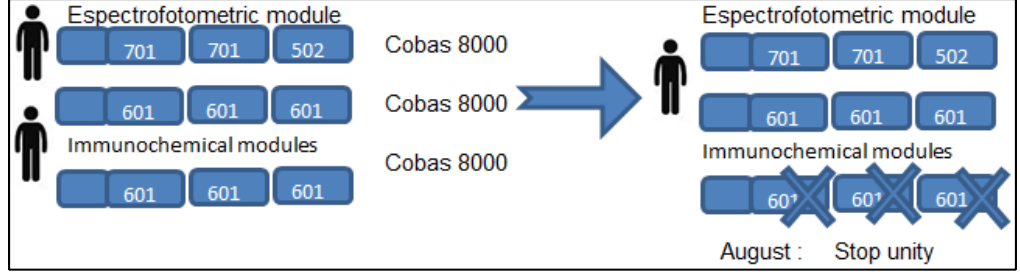
Figure 1. One operating unit Cobas 8000-701 and two units Cobas 8000-601 with staff allocation and reduction of substitutes during August. Finally, with one unity Cobas 8000-601 operating in month august.